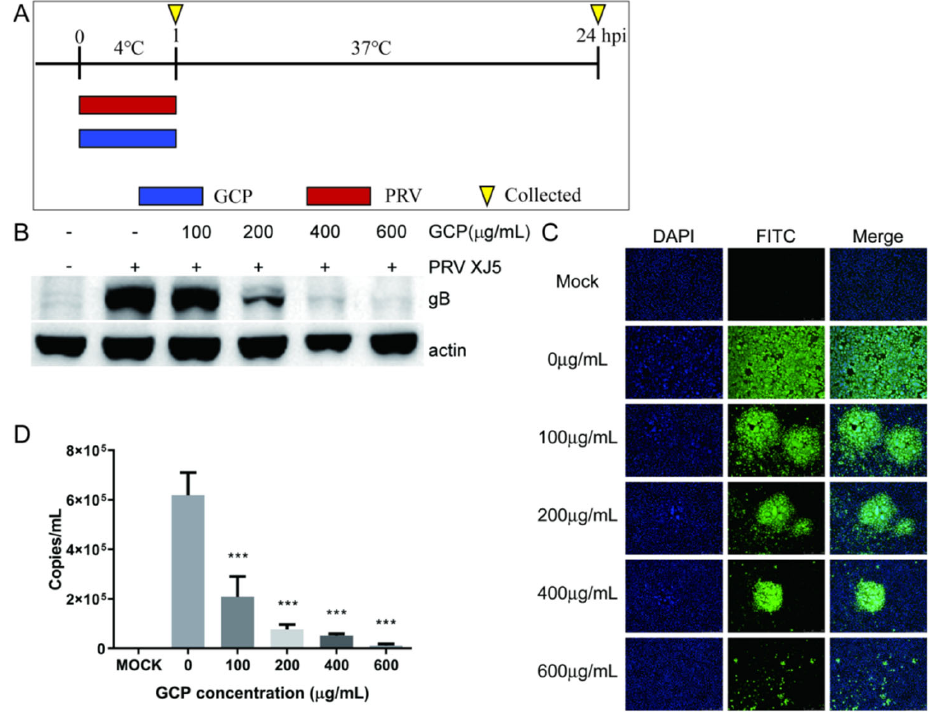
Figure 5. GCP decreased PRV binding ( A ) PK-15 cells were incubated with PRV XJ5 (MOI = 0.1) and GCP at 4 °C for 1 h, then cells were collected at 1 hpi or 24 hpi. ( B , C ) At 24 hpi, the expression levels of gB protein and actin were analyzed by Western blot and the internalized virus was detected by immunofluorescence assay. ( D ) At 1 hpi, the copy numbers of PRV DNA were quantified by qRT-PCR. All results were obtained from three independent experiments and were presented in means ± SD (*** p 0.001).